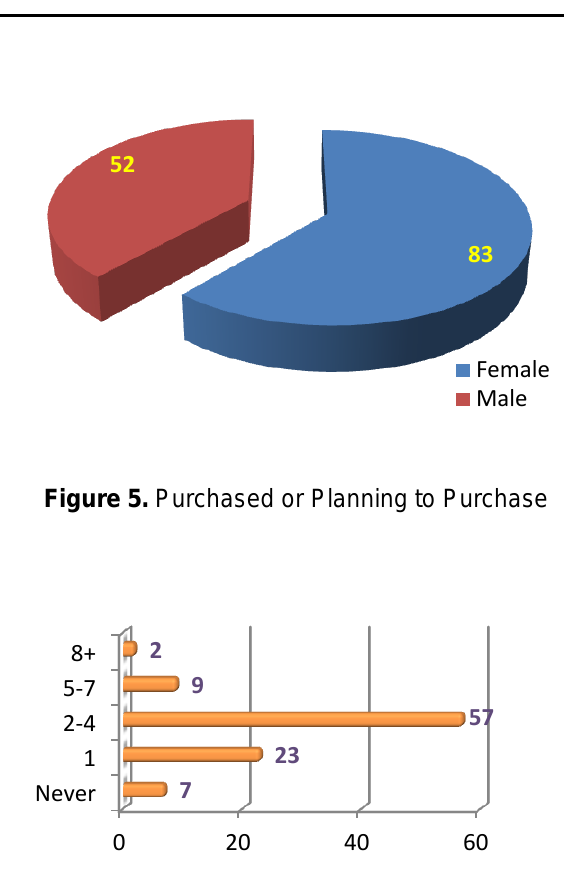
Figure 6. Number of Purchasing